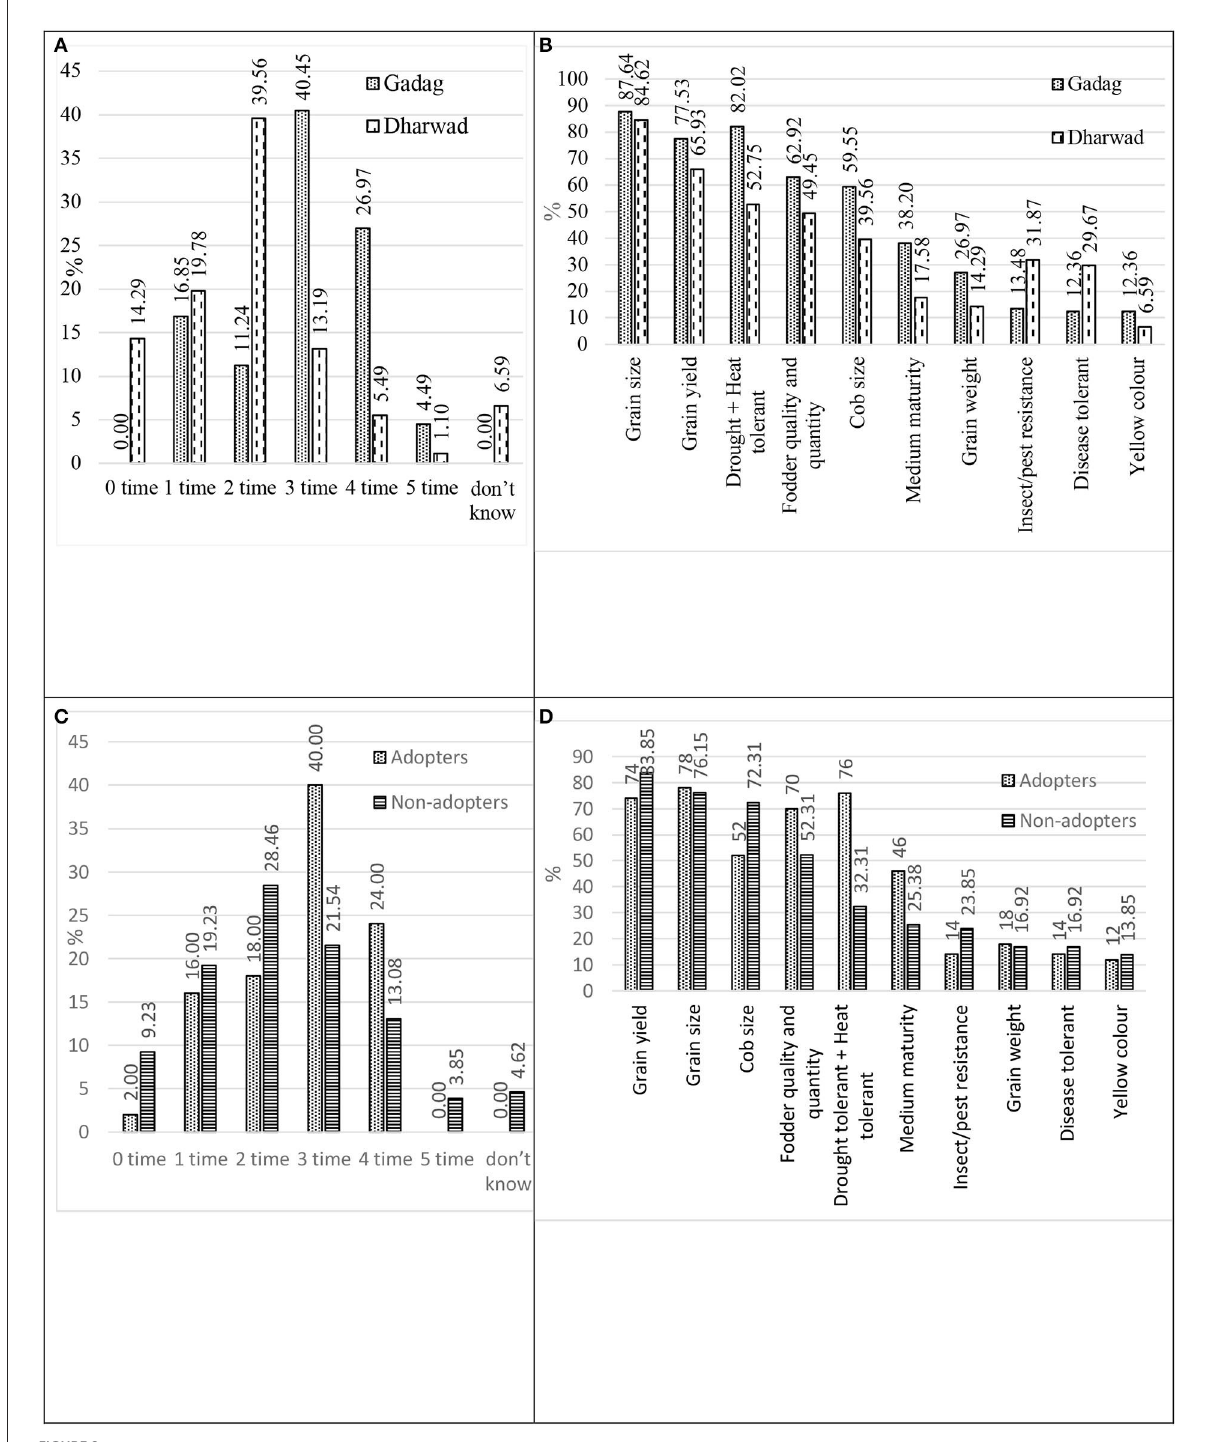
FIGURE2 Farmer’s perception of drought frequency and criteria of the selection of maize hybrid in the study location. (A) Farmer’s perception of drought frequency in the last 10 years, by sample districts. (B) Criteria for the selection of maize hybrid by sample districts. (C) Adopter and non-adopter farmer’s perception of drought frequency in the last 10 years. (D) Criteria for the selection of maize hybrid by adopters and non-adopter farmers in the study